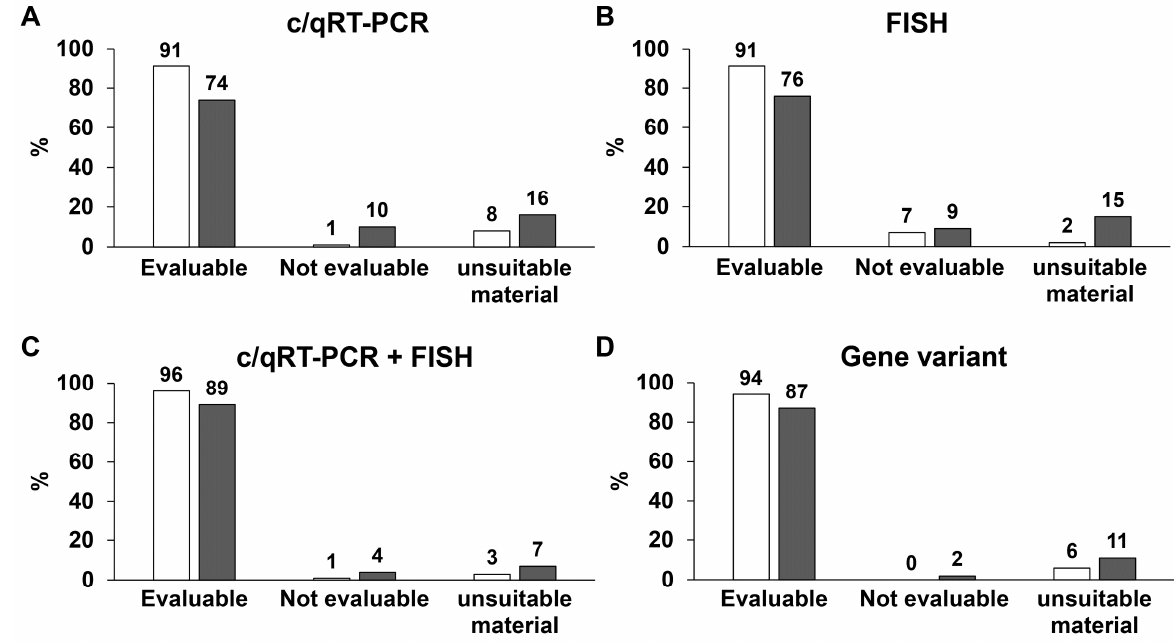
Figure 2. Evaluation of the analytical quality of the samples under examination comparing frozen tissue vs. FFPE tissue, based on the type of analysis. ( A ) Analytical quality of c/qRT-PCR tests on frozen tissue samples vs. FFPE tissue. ( B ) Analytical quality of FISH tests on frozen tissue samples vs. FFPE tissue. ( C ) Analytical quality of combination of the two methods c/qRT-PCR + FISH tests on frozen tissue samples vs. FFPE tissue. ( D ) Analytical quality of gene variant tests on frozen tissue samples vs. FFPE tissue. White bars represent frozen tissue samples, and grey bars represent FFPE tissue samples. Table 2. Sensitivity and specificity of the molecular analyses in the diagnosis of different subtypes of BSTS.